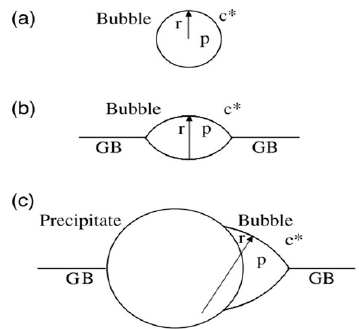
Figure 2. Illustration of interfacial effects on bubble nucleation at high temperatures; ( a ) spherical nucleus in the matrix, ( b ) lenticular nucleus at a grain boundary (GB), ( c ) truncated lenticular nucleus at a GB-precipitate, all assumed to have the same volume [8].